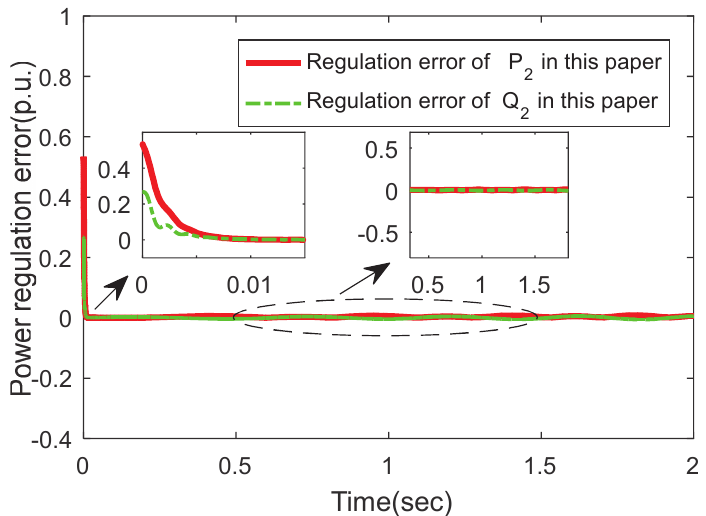
Figure 15. Tracking error of P 2 and Q 2 in this